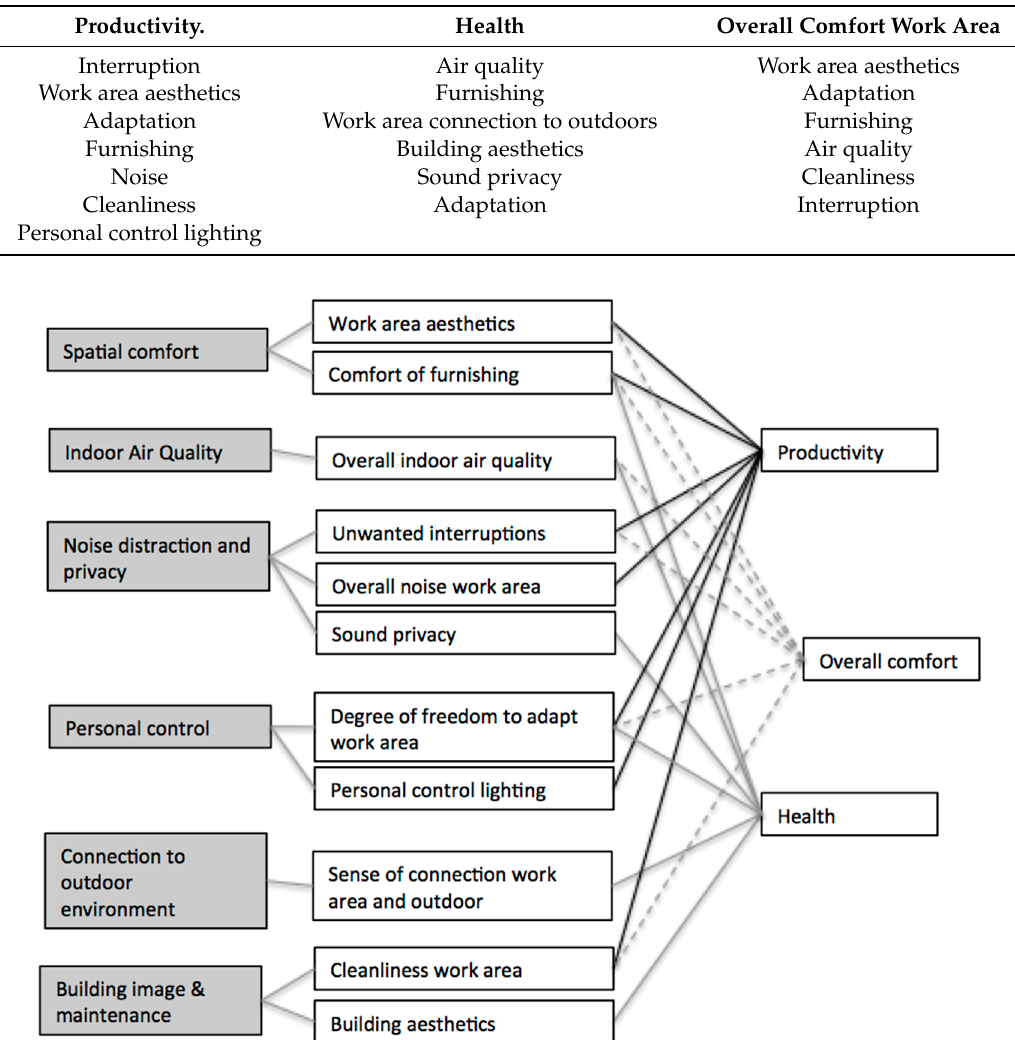
Table 4. Ranking of best-performing features of open-plan o ffi ces for predicting perceived productivity, health, and overall comfort of work area.